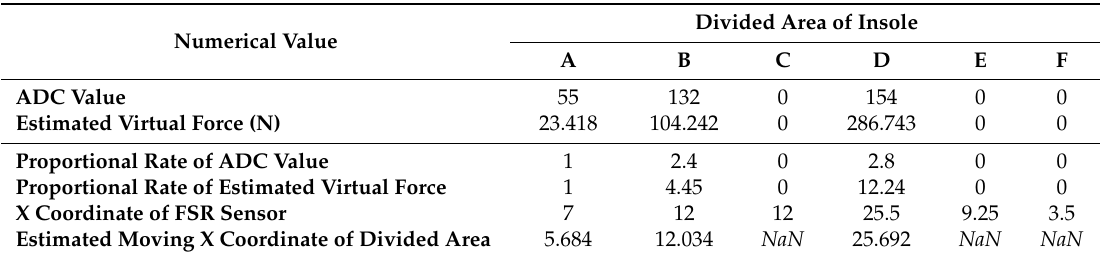
Table 3. Numerical values of frame in Figure 9.